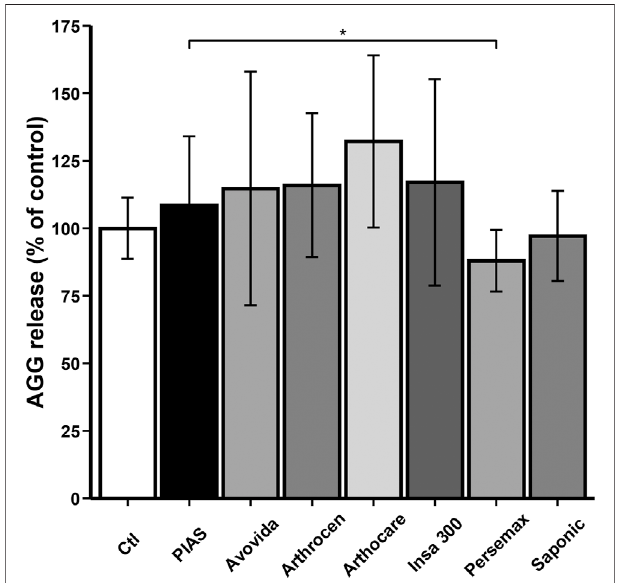
FIGURE3| EffectofASUproductstestedontotalAGGproduction. The chondrocytes were cultured for 12 days either without any ASU (negative control, Ctl) or with 10 µg/ml of either PIASCLEDINE-ExpASU ® (PIAS) or one of the six other nutraceutical products being evaluated in comparison, namely, Avovida, Arthrocen, Arthocare, Insaponi fi able 300 (Insa 300), Persemax, or Saponic. Each product has been tested on six independent cultures. Each culture condition was performed in triplicates. The results are expressed as the percent control and represented by the mean ± SD. * p < 0.05 versus PIASCLEDINE-ExpASU ® .